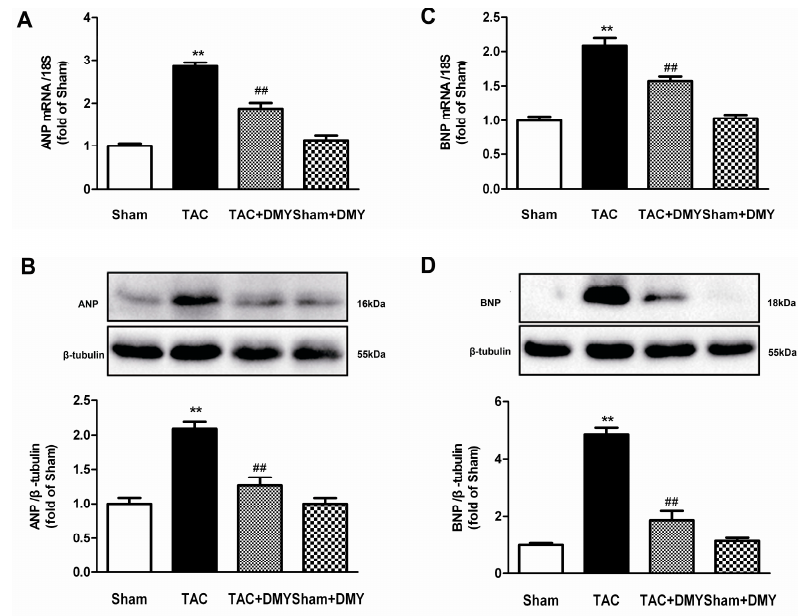
Figure 5. Effect of DMY on hypertrophic gene expression in the myocardium of mice after TAC. ( A , B ) Atrial natriuretic peptide (ANP) mRNA and protein expression were respectively quantified by real-time PCR and western blot. ( C , D ) Brain natriuretic peptide (BNP) mRNA and protein expression were respectively quantified by real-time PCR and western blot. 18S was used as a housekeeping gene. β -tubulin was used as a loading control. ** p < 0.01 versus Sham, ## p < 0.01 versus TAC ( n = 5–8).